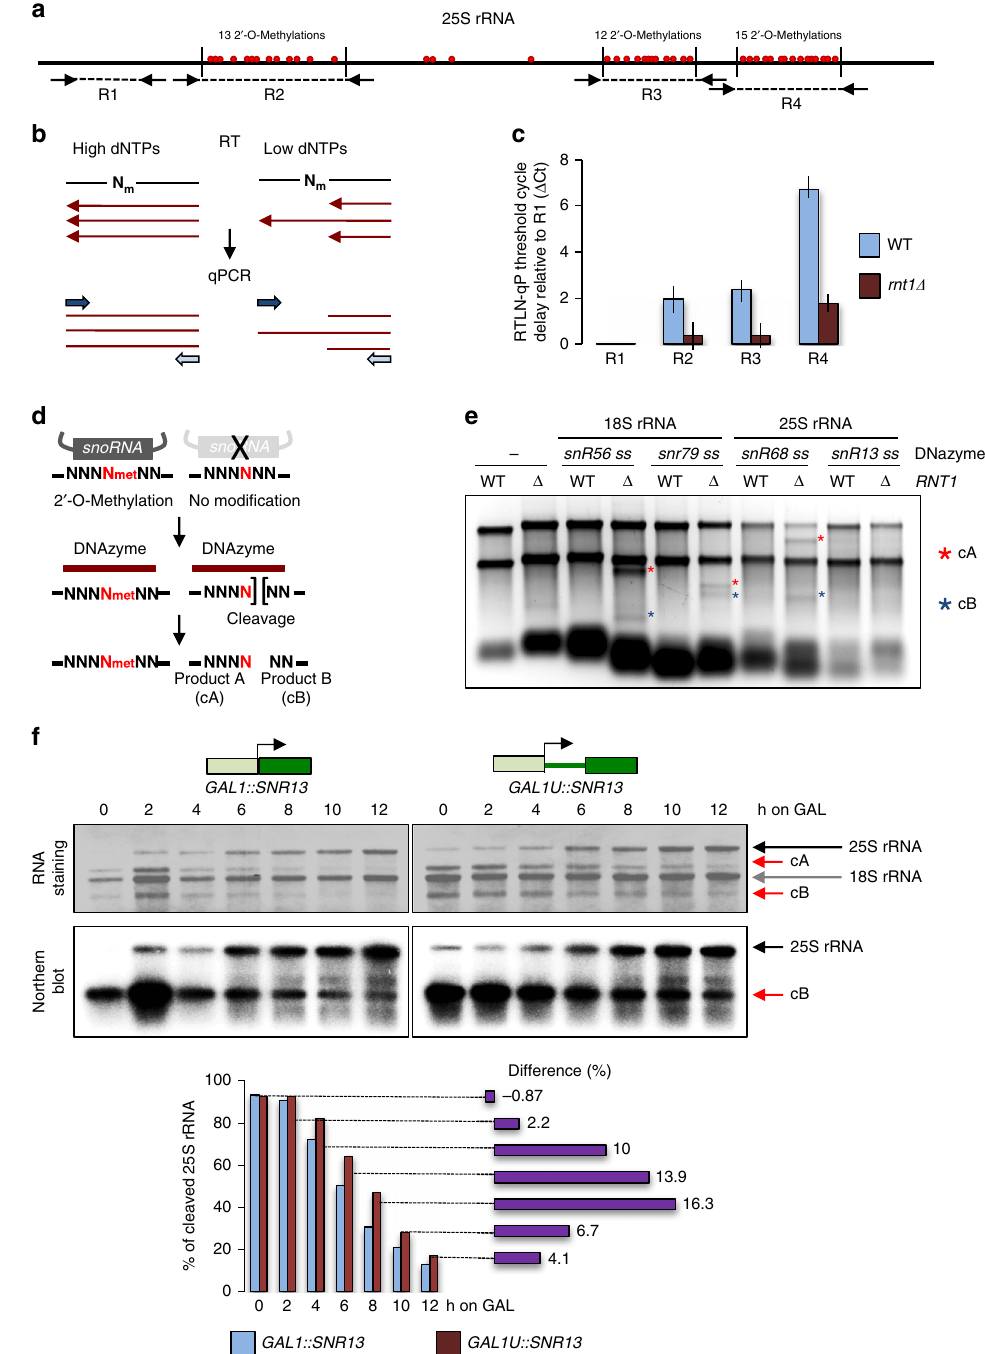
Fig. 6 Lack of snoRNA 5 ʹ processing affects 2'-O-methylation of rRNA. a Diagram showing 25S rRNA methylation sites and amplicon locations for RTLN-qP analysis (R1 – 4). b Principles of RTLN-qP technique showing that reverse transcriptase pauses and terminates upstream of modi fi ed nucleotide at low dNTP concentration. c Delay in RTLN-qP threshold cycle (Ct) of amplicons located over the 25S rRNA methylation clusters in WT versus rnt1 Δ strains re fl ecting cDNA levels. The R2 – R3 Ct were normalized to the delay of RTLN-qP reaction over non-methylated R1 giving a Δ Ct value as graphically presented. Average from three independent biological replicates is shown. Error bars represent standard deviation. d Diagram illustrating DNAzyme-dependent cleavage assay. e Analysis of site- speci fi c 18S and 25S rRNA methylation using DNAzyme-dependent assay. RNA was visualised by EtBr staining in a denaturing agarose gel. Cleavage products cA and cB are marked by asterisks. f Kinetics of snR13-dependent 25S rRNA methylation mediated by WT snR13 and 5 ʹ extended snR13e revealed by Northern blot of DNAzyme-dependent cleavage. Upper panels show methylene blue staining of RNA transferred on the membrane while lower panels are Northern blot using oligo probe located downstream of the snR13-dependent methylation sites. Arrows indicate 25S and 18S rRNA positions as well as products of the DNAzyme- dependent cleavage of 25S rRNA (fragments cA and cB). Quanti fi cation of the Northern blot indicating percent of cleaved mature 25S rRNA is shown